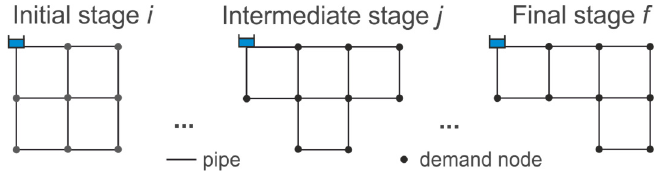
Figure 4. Creation of intermediate stage WDSs on basis of the master plan and the initial and final stage.